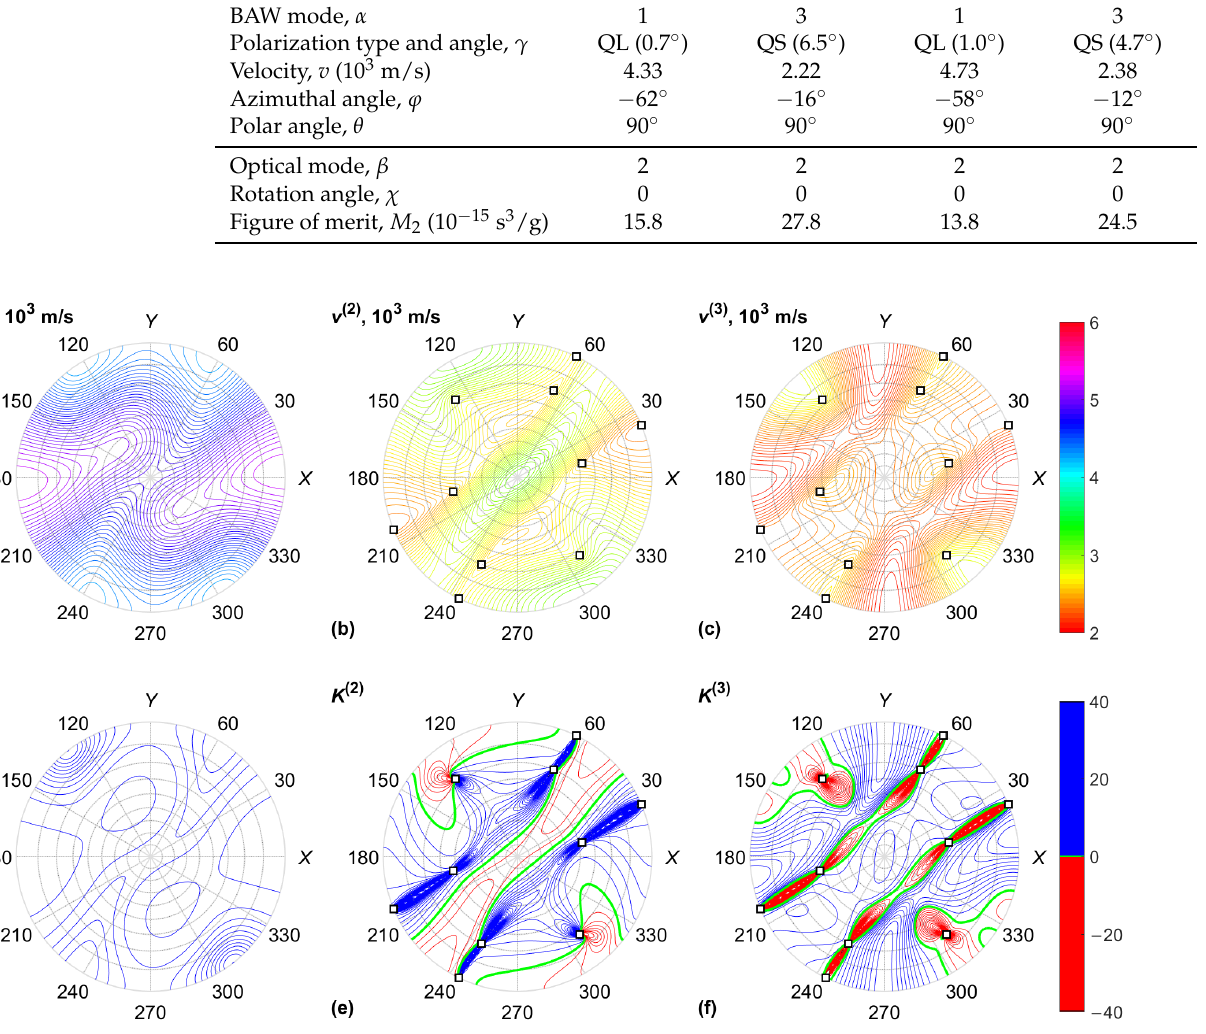
Table 1. Maxima of the AO figure of merit in KGW and KYW crystals.